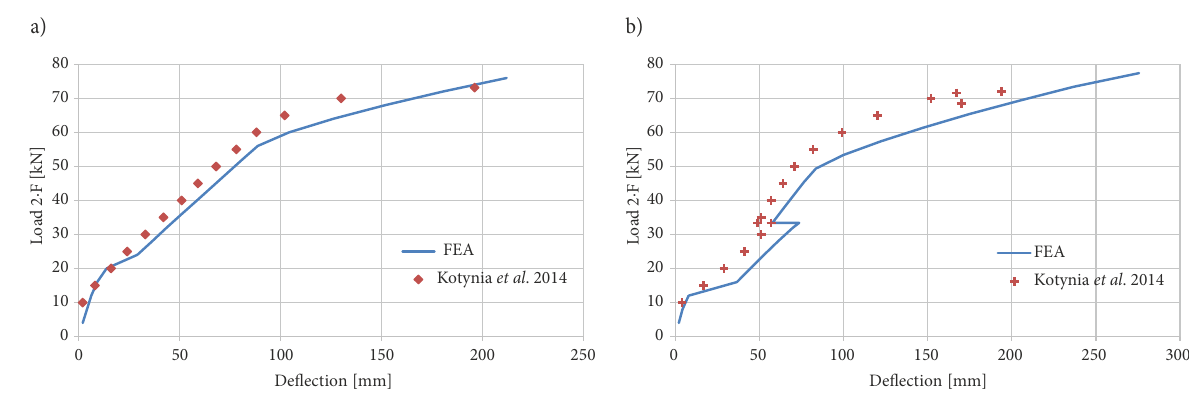
Fig. 7. External load vs deflection, curves predicted numerically and points from research. Reinforcement 4 ∅ 16: a – “asp” series beams; b – “asp-e” series beams (Kotynia et al. 2014)